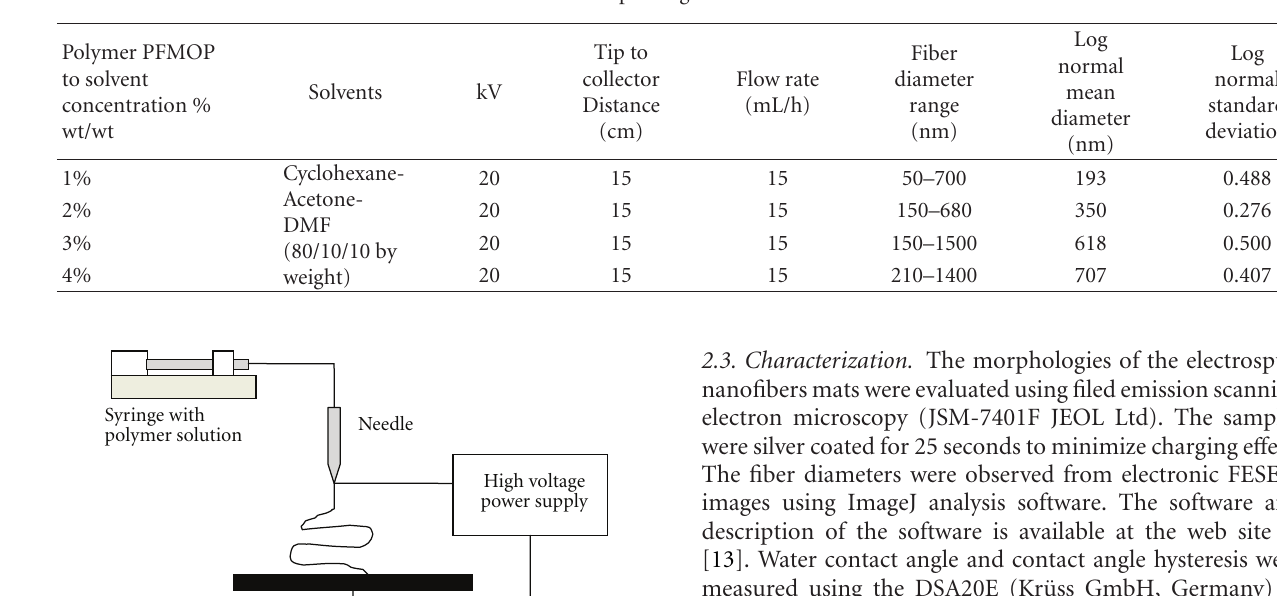
Table 1: Electrospinning conditions of PFMOP.